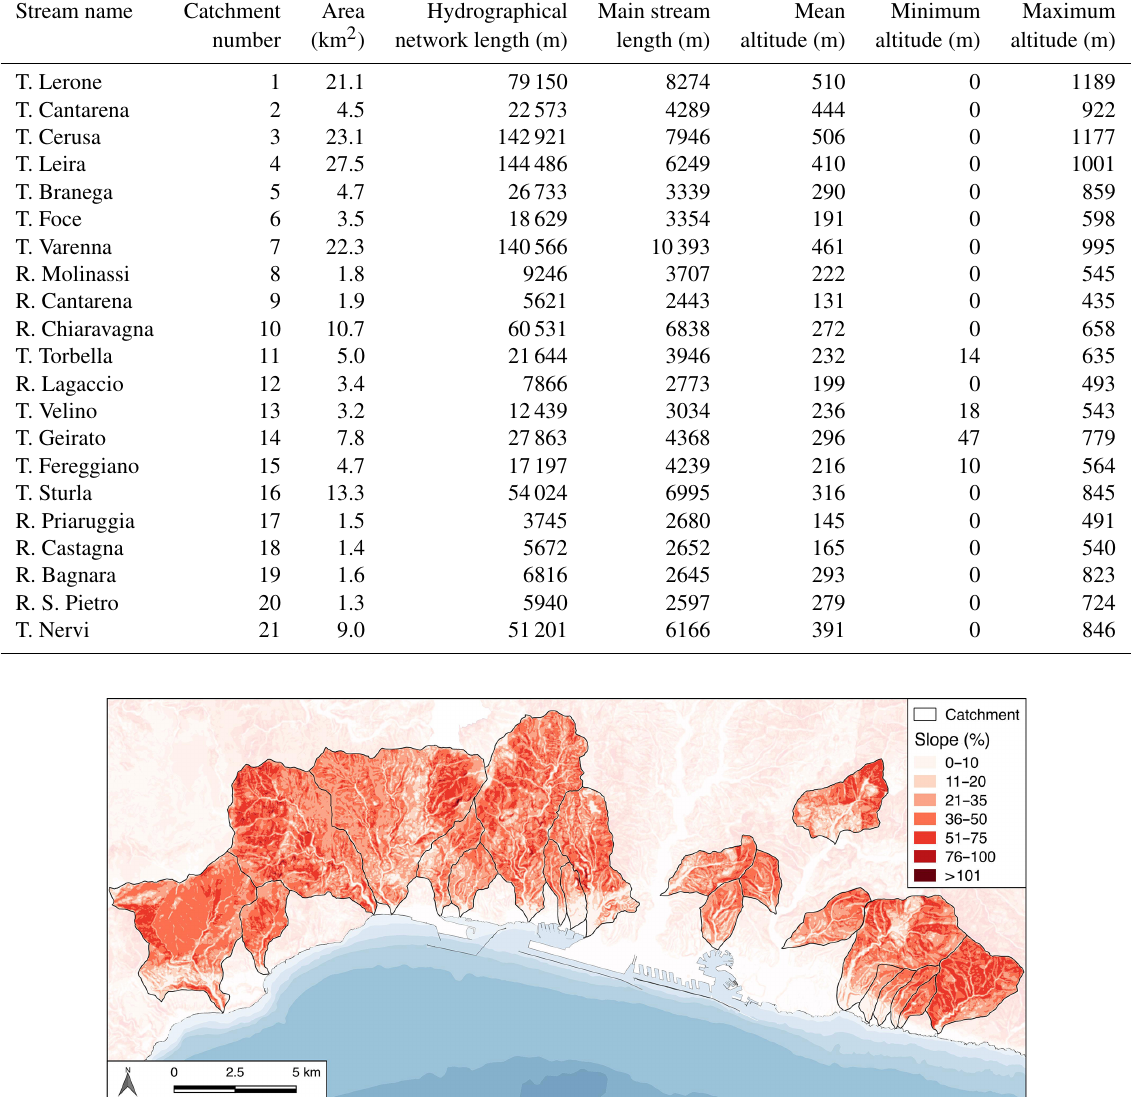
Figure 2. Gradient in the studied